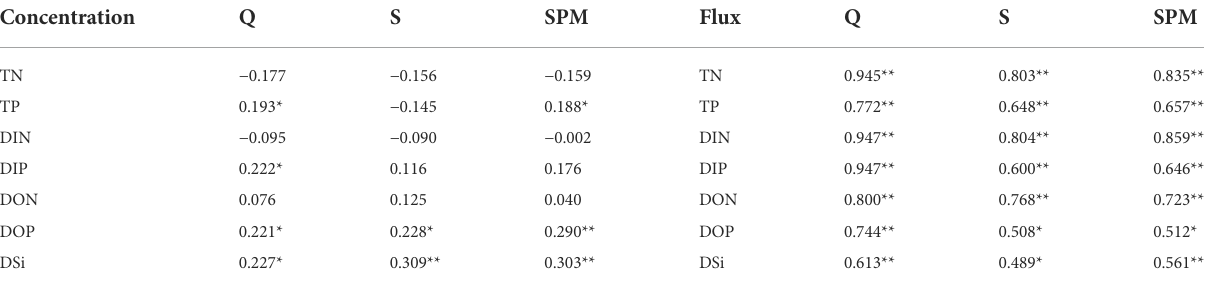
* represents p < 0.05. ** represents p <